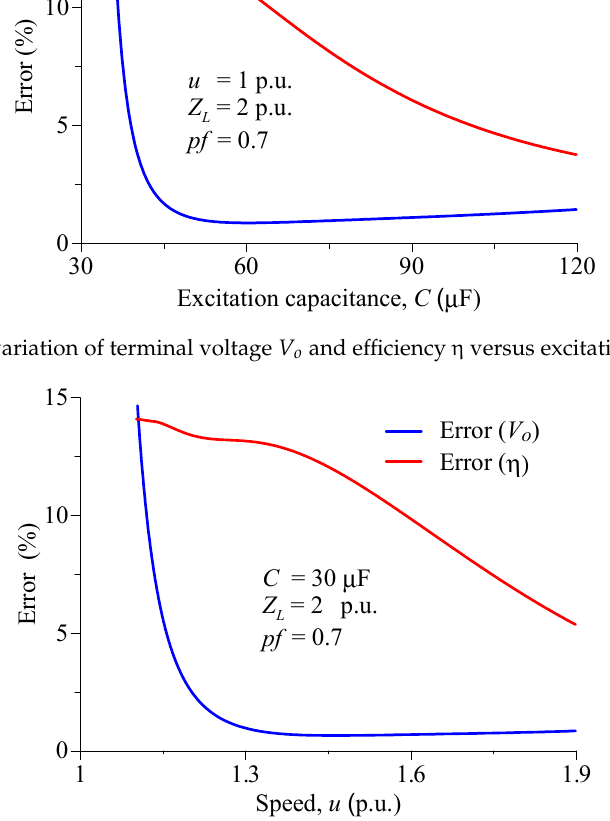
Figure 17. Error variation of terminal voltage V o and efficiency η versus speed u .